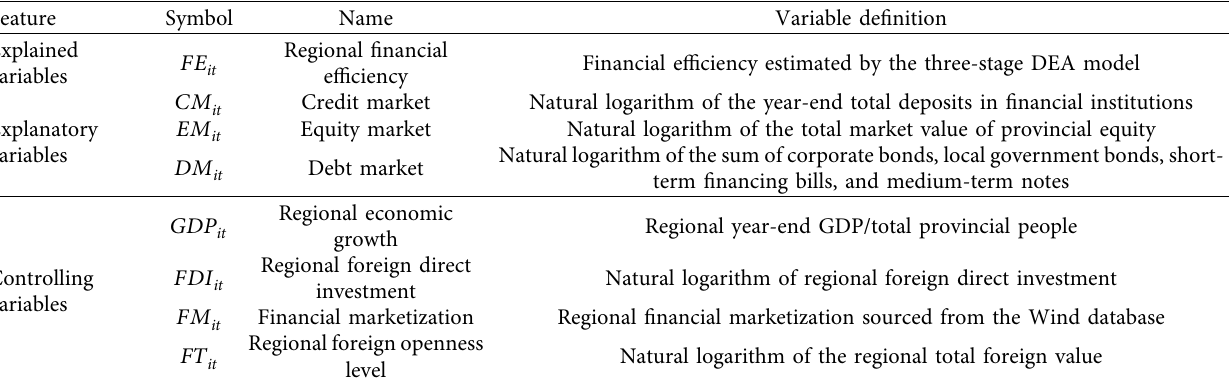
Table 3: Definitions of the main variables in equation